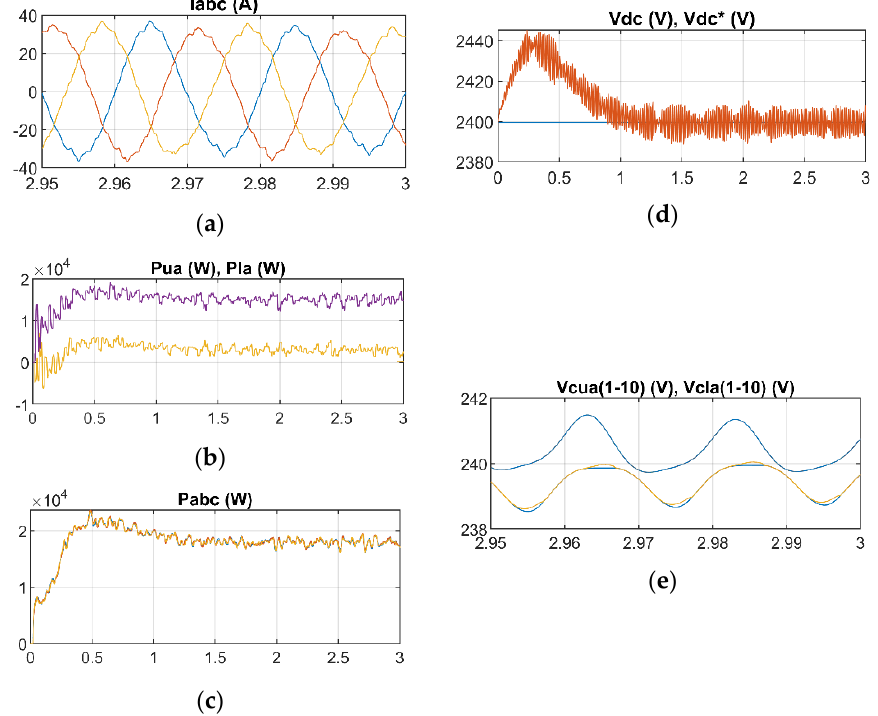
Figure 13. Simulation plots when the generation has a large imbalance between arms. ( a ) Output currents. ( b ) Power of the upper and lower arms. ( c ) Power delivered by each phase. ( d ) Voltage on the DC link. ( e ) Capacitor voltages.